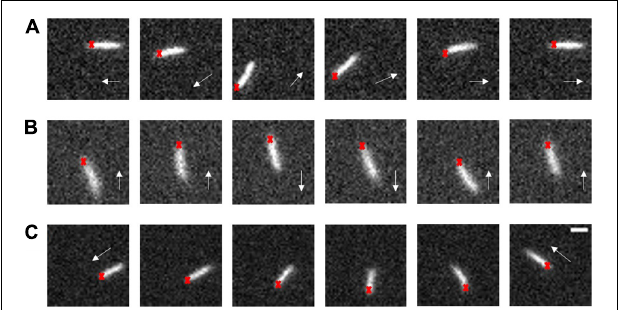
FIGURE 1 | Typical swarm cell reversal on the swarm agar plate of the (cid:49) cheY strain. (A) The cell reversed without changing the orientation of its long axis, (cid:49) angle ∼ π . (B) The cell exhibited successive reversals, (cid:49) angle ∼ 0. (C) The cell body underwent a significant rotation, (cid:49) angle depended on the degree of the body rotation. The red crosses represent the cell head at the beginning and the white arrows indicate the instantaneous velocity direction of the cell, scale bar = 3 µ